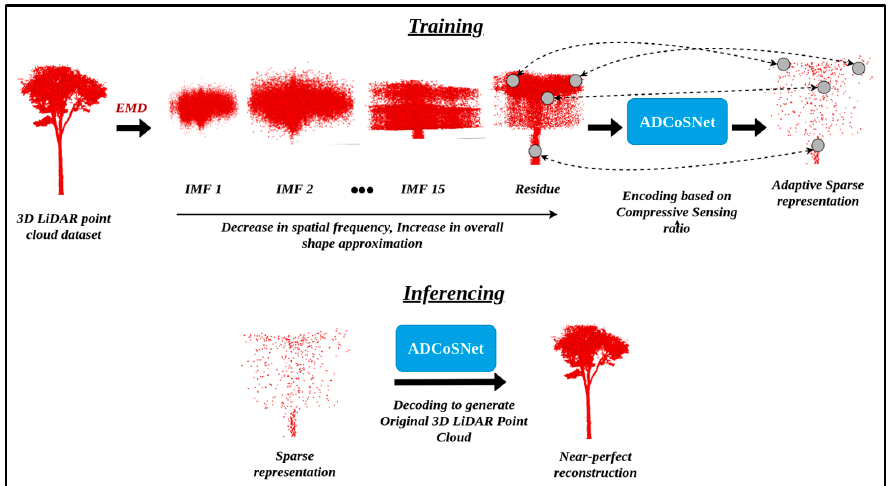
Figure 1. Illustration of the development workflow of the ADCoSNet. In 3D point clouds, the EMD ‐ derived Residue signifies the overall shape of the 3D point cloud and can be used for sampling and generating sparse representations. Although the illustration represents a single 3D geometry, the principle is coherent for 3D LiDAR scenes, with increased complexity due to the size of the dataset.